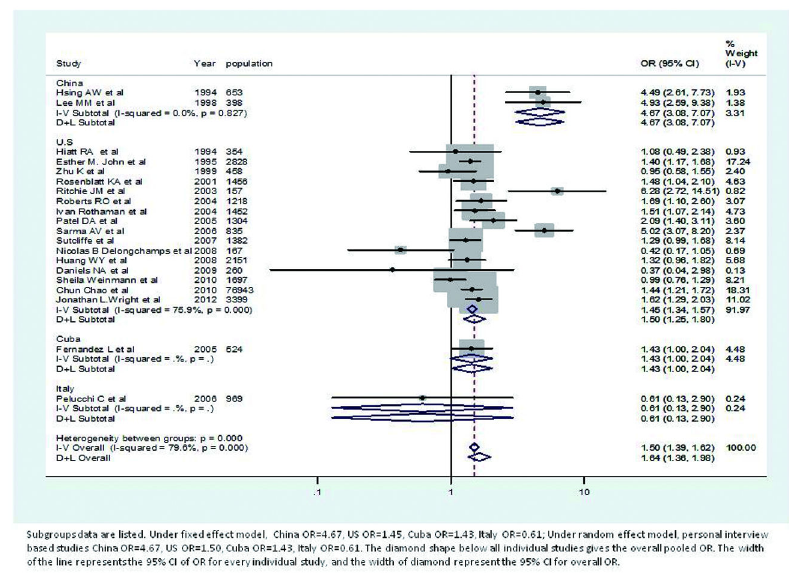
Figure 5. Forest plot of odds ratio under fixed effect and random effects model, based on countries.